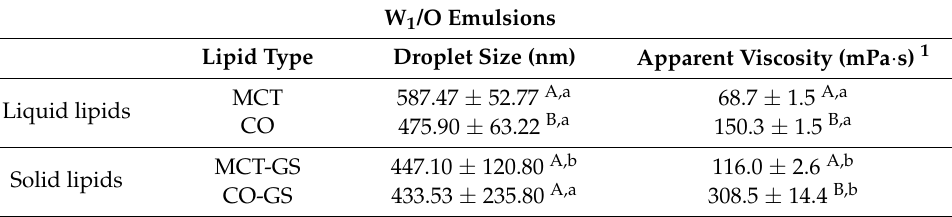
Table 2. Droplet size (nm) and apparent viscosity (mPa · s) of chlorophyllin-loaded W 1 /O emulsions formulated with different lipid phases consisting on medium chain triglyceride (MCT) or corn oil (CO) and without or with glyceryl stearate (GS). Different upper case letters (A, B) indicate significant differences between lipid type. Different lower case letters (a, b) indicate significant differences between different lipid